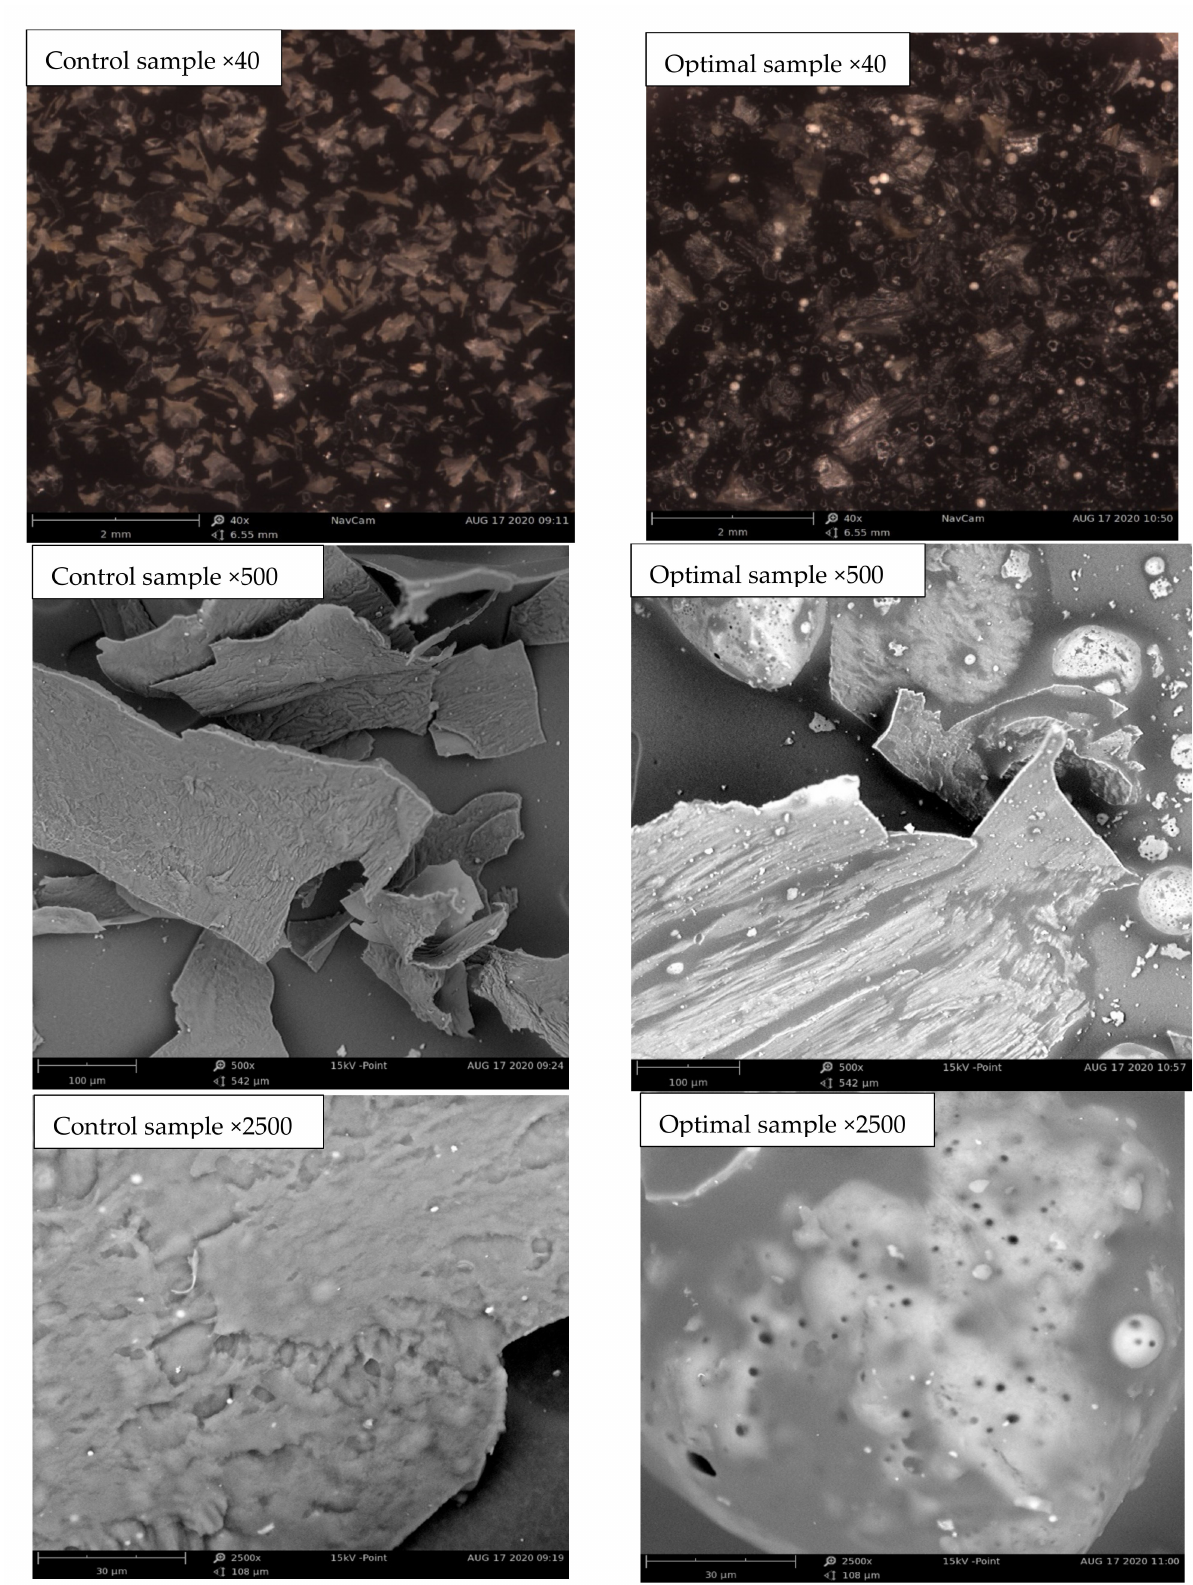
Figure 7. SEM micrographs of the control and optimal samples at different